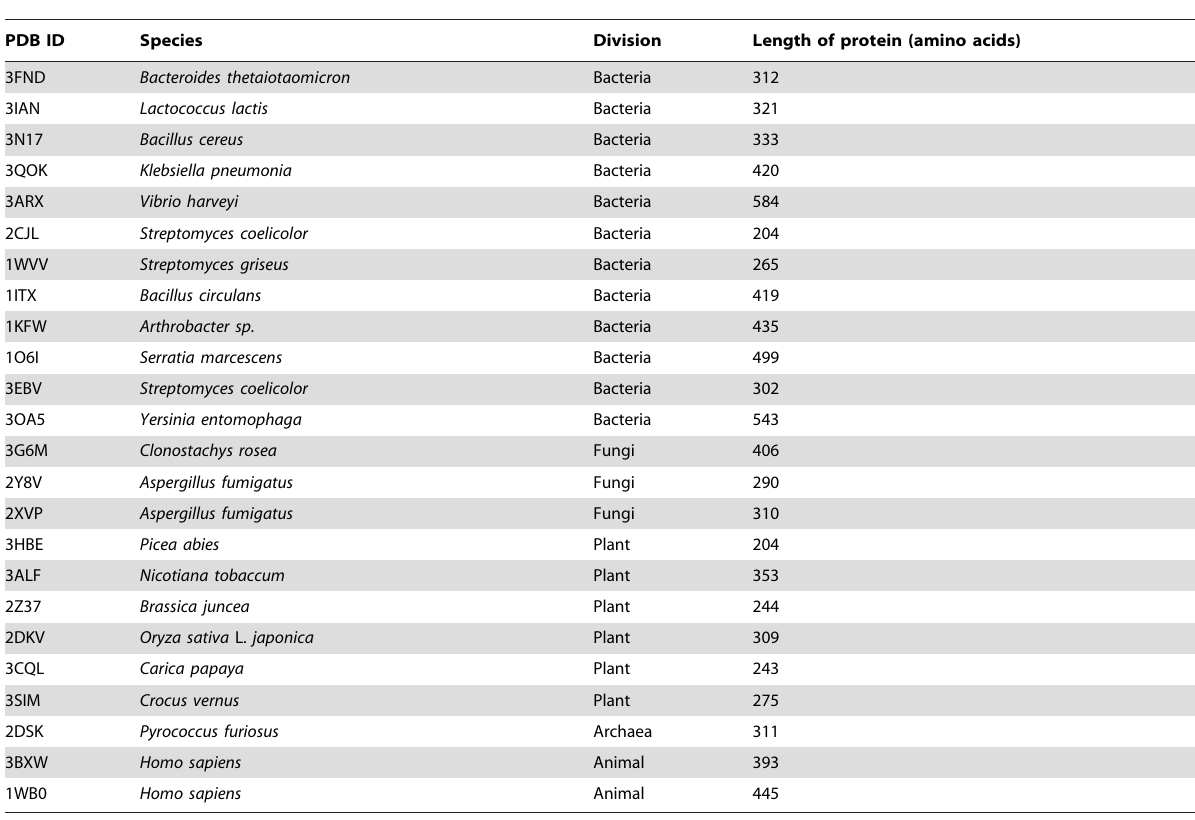
Table 1. List of amino acid sequences of Chitinase protein used in the present